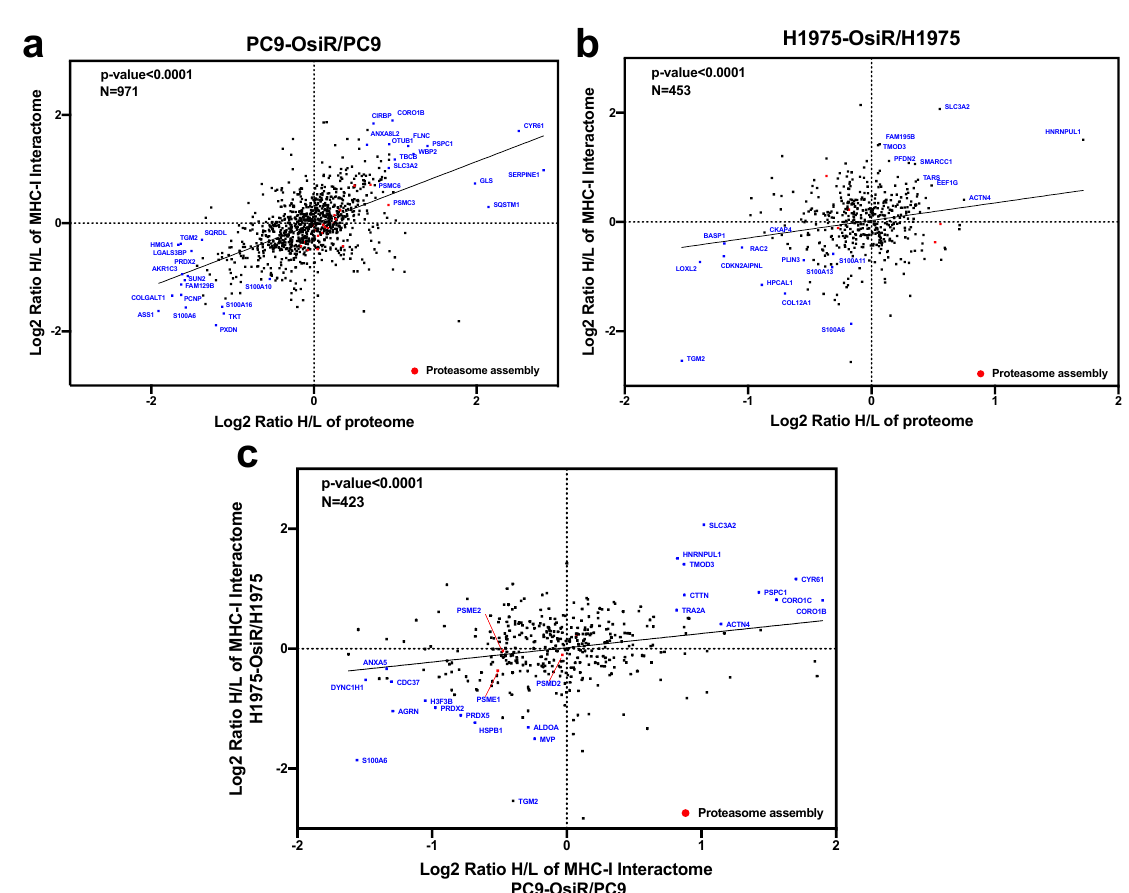
Figure 8. Correlation analysis of proteome and interactome reveals key functional proteins in altered antigen presentation signaling in OsiR cells. ( a , b ) Correlation analysis of proteomic and interactomic datasets in PC9-OsiR/PC9 ( a ) and H1975- OsiR/H1975 lung adenocarcinoma cells ( b ). ( c ) Correlation analysis of the HCIs identified both in PC9-OsiR/PC9 and H1975-OsiR/H1975 experiments.